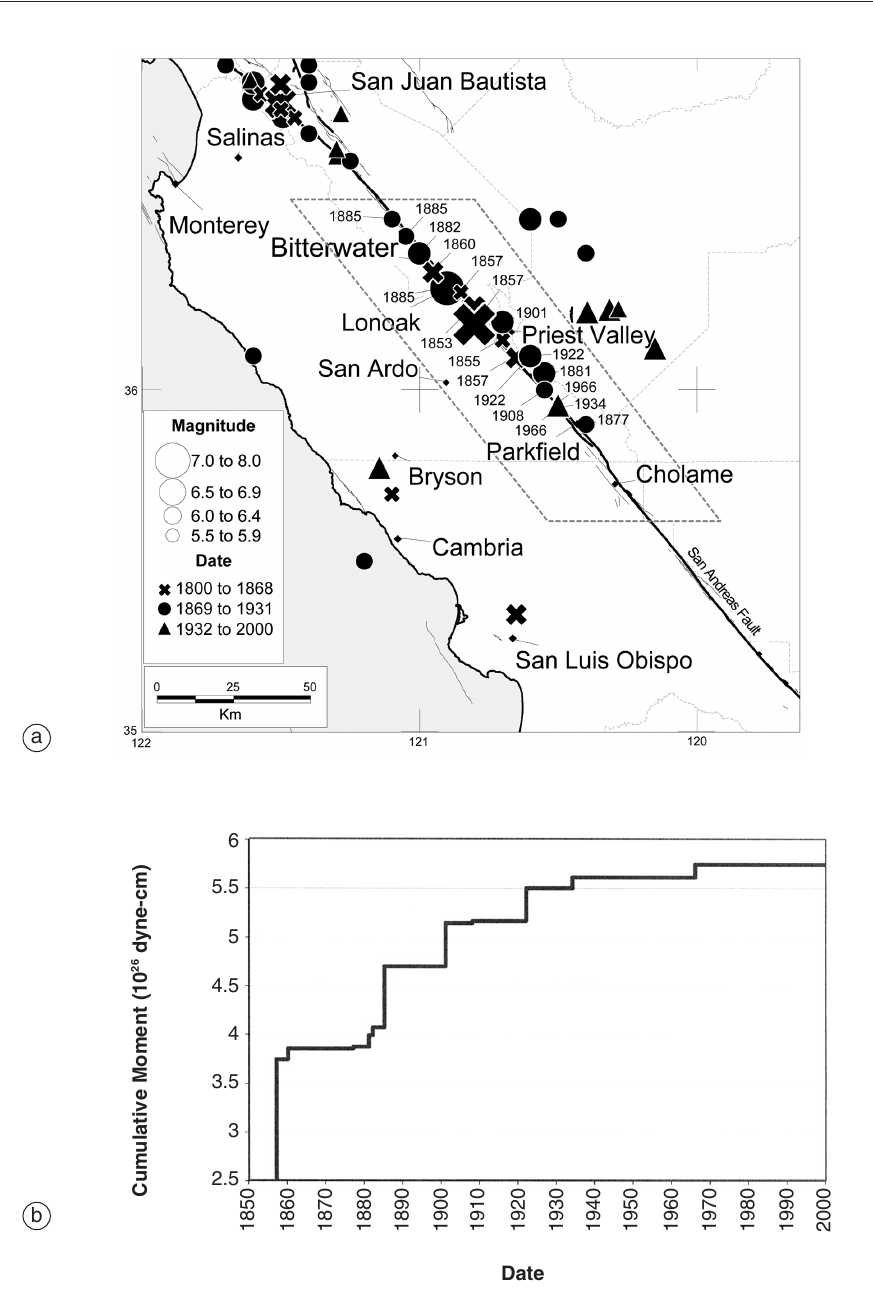
Fig. 6a,b. a) Epicenters of M ≥ 5.5 earthquakes in the Parkfield-Bitterwater region and surrounding areas. Sym- bol size is proportional to M and shape indicates time period. The dashed region is that considered in fig. 6b (Modified from Toppozada et al. , 2002). b) Cumulative seismic moment released in the Parkfield-Bitterwater zone of the San Andreas fault from 1857 to 2001 (Modified from Toppozada et al. , 2002).